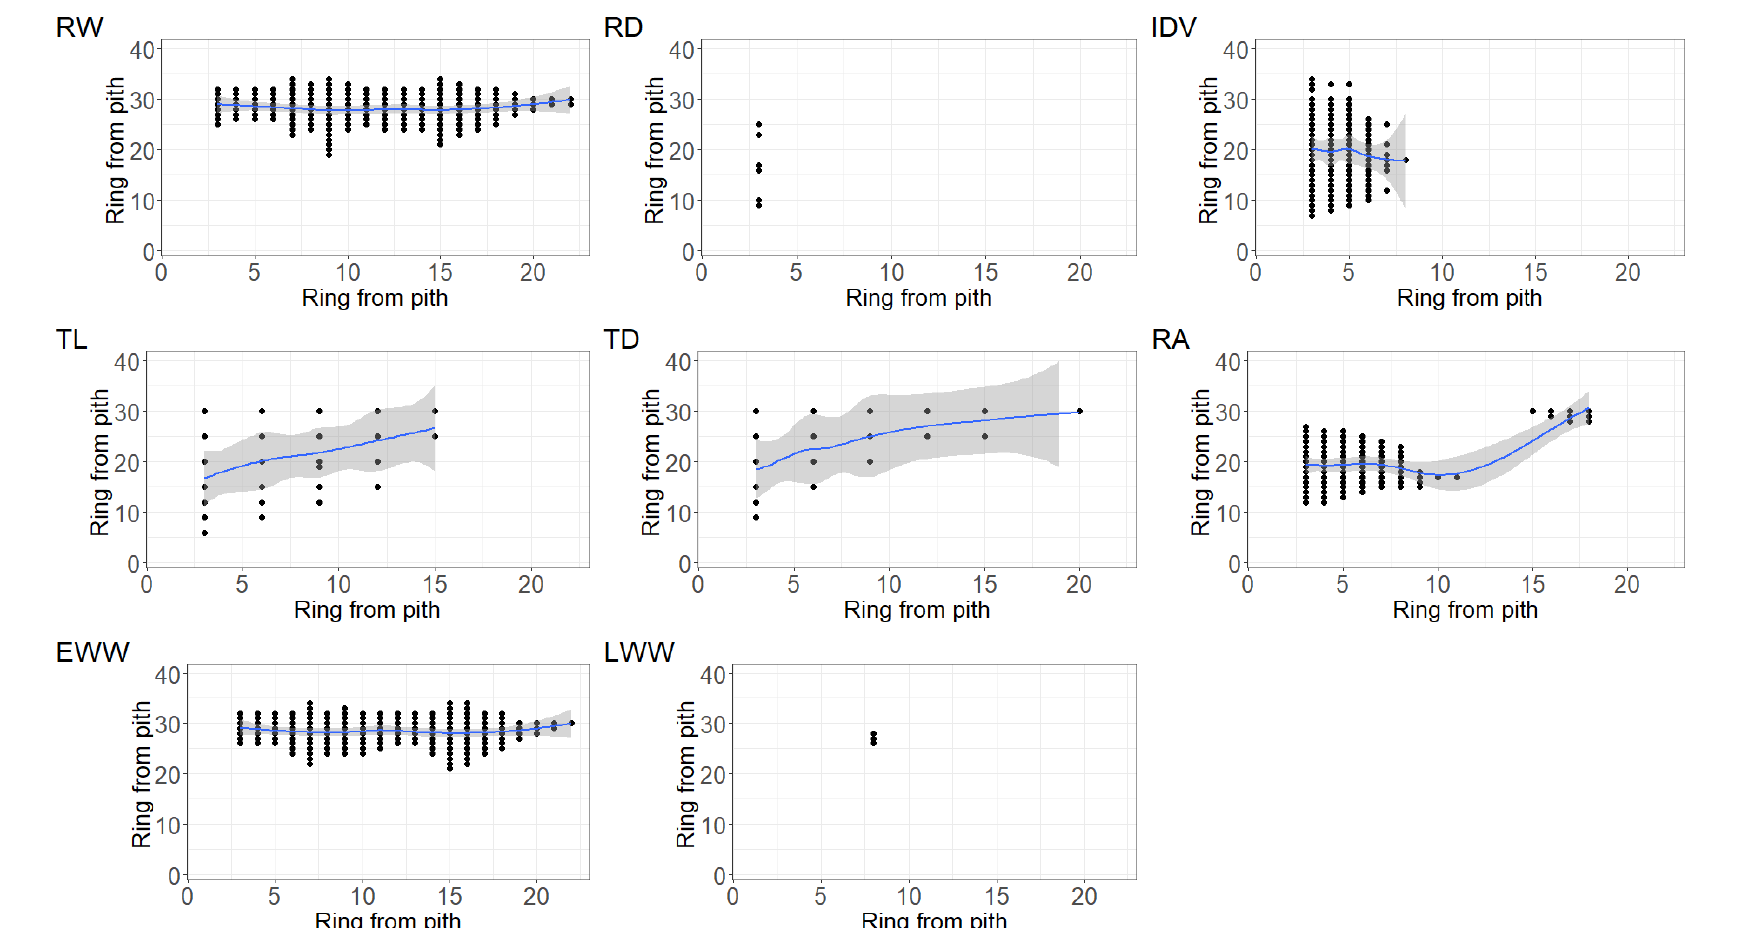
Figure 1. Outcomes of the models comparing a given ring with, respectively all other rings at breast height. The blue line represents best fit and shaded region the 95% confidence level interval for predictions. Only significant differences (black dotes, p > 0.05) were shown ( p -value adjustments for multiple comparisons using Bonferroni correction). RW: ring width, RD: ring density, IDV: intra-ring density variation, TL: tracheid length, TD: tracheid diameter, RA: ring area, EWW: earlywood width, and LWW: latewood width.